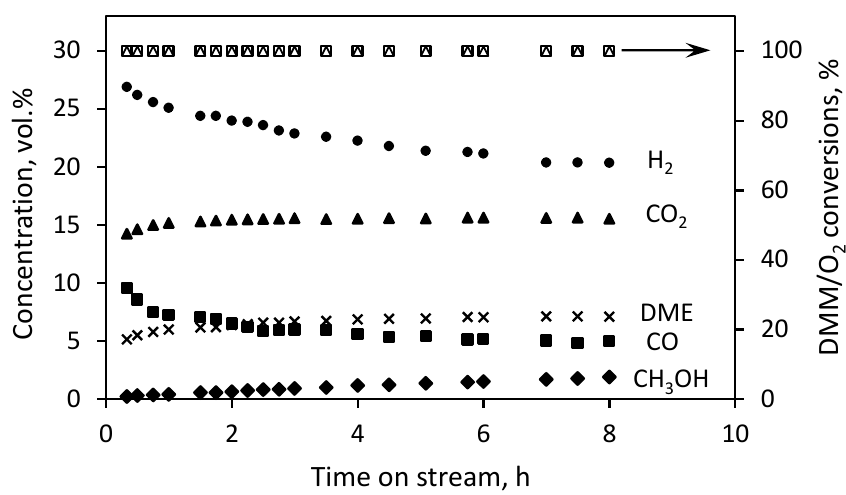
Figure 2. E ff ect of time-on-stream on DMM conversion and product concentrations in DMM partial oxidation over the CuO-CeO 2 / γ -Al 2 O 3 catalyst. Reaction conditions: P = 1 atm; T = 280 ◦ C; GHSV = 10,000 h − 1 ; Inlet composition: CH 3 OCH 2 OCH 3 :O 2 :N 2 = 16.7:16.7:66.6 vol.%.